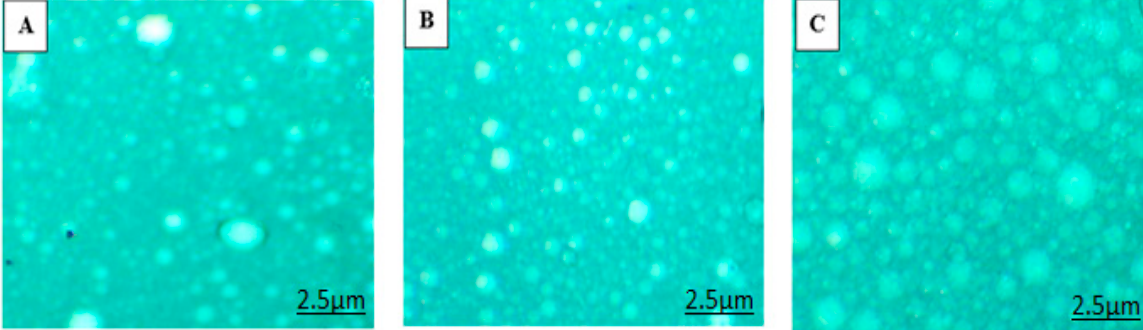
Figure 3. Microscopic image of formulated ( A ) simple nanoemulsions (SNE), ( B ) chitosan-decorated nanoemulsions (CNE) and ( C ) multiple nanoemulsions (MNE).